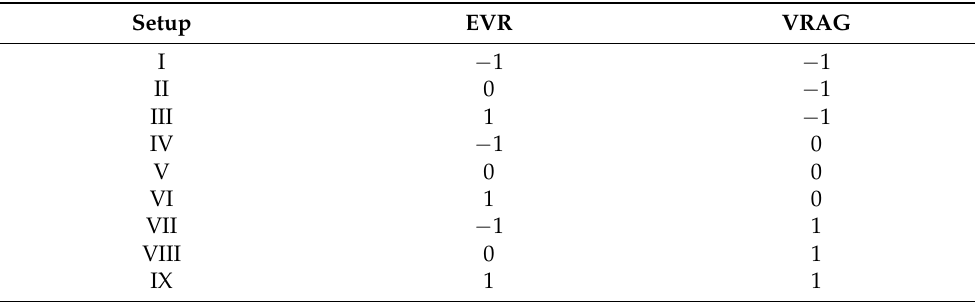
Table 3. Experimental design of the 3D-printing process.